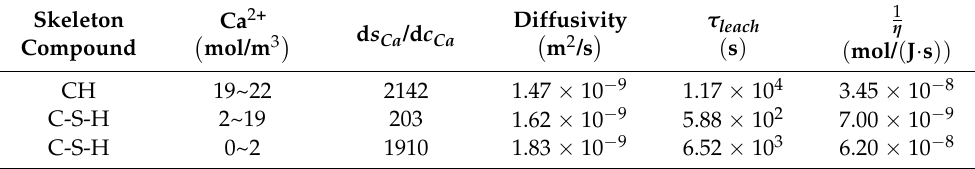
Table 3. Parameters for the solid-phase calcium disequilibrium decomposition